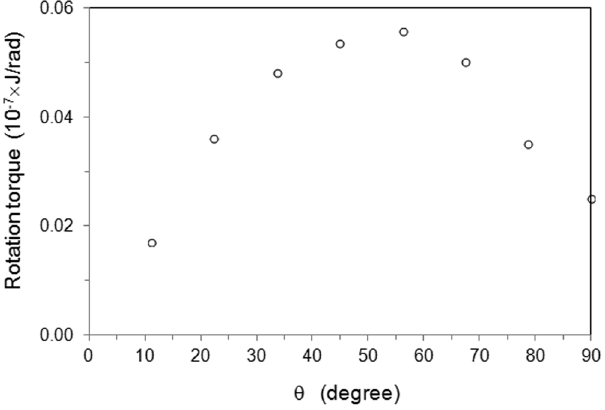
Figure 4. The electric-current-induced torque is dependent on the incline